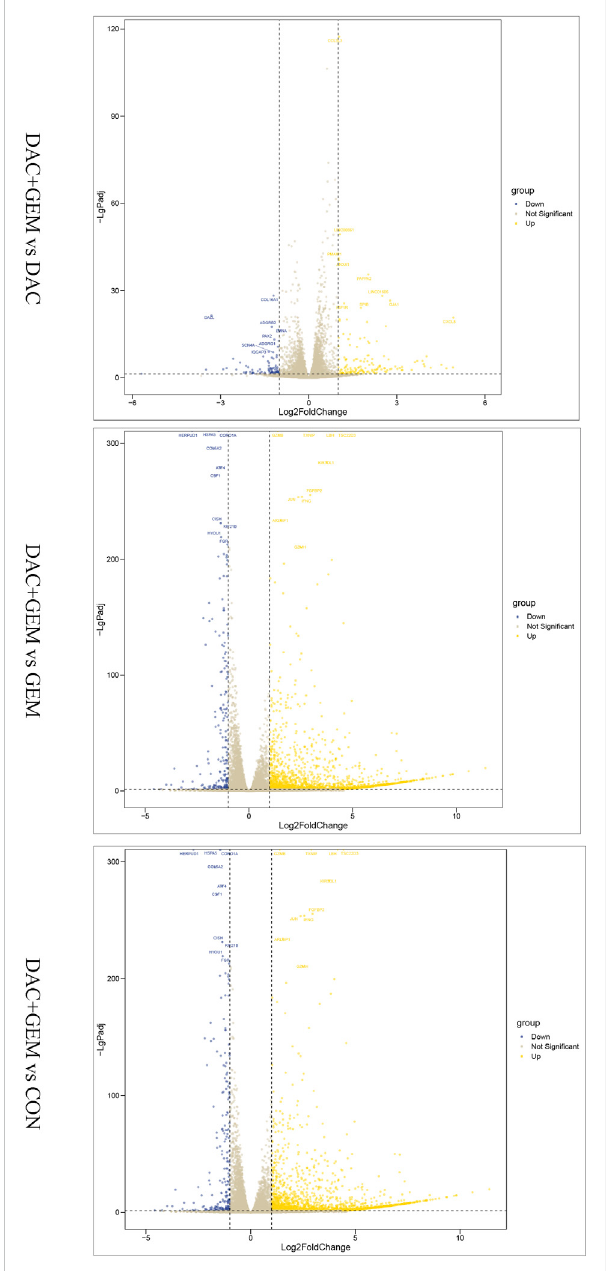
FIGURE 4 Combination of DAC and GEM induced transcriptome level changes. After treatment with the indicated dose of DAC and GEM alone or in combination, a volcano plot of differentially expressed genes in the combination group was compared with each single drug group or control group in NK92MI